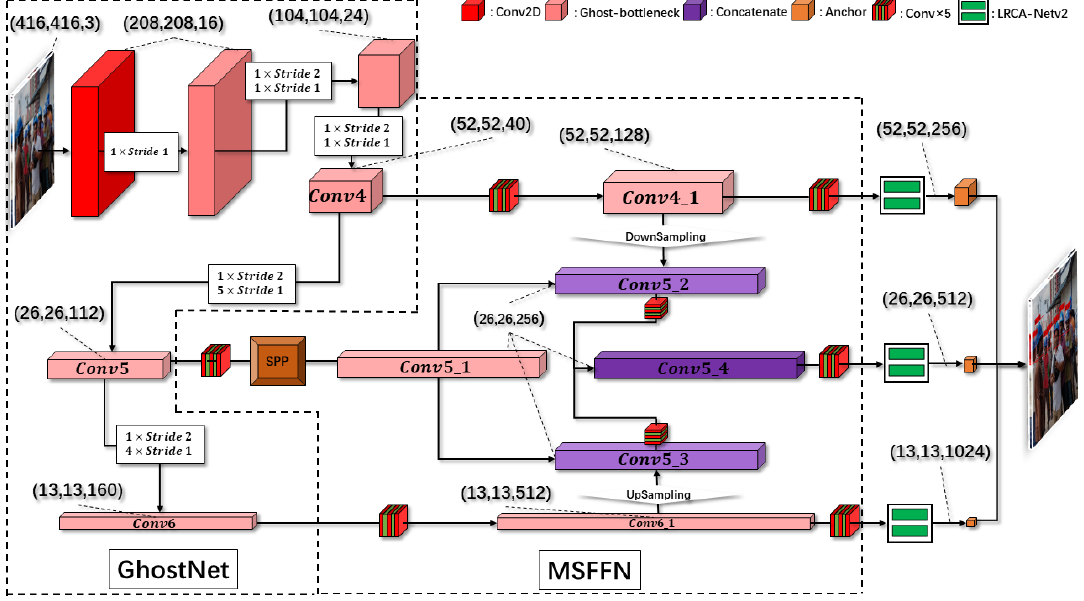
Figure 1. The network framework of a helmet-wearing detection algorithm is proposed in this pa- per.